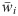
Analysis of market-order strategies.A, Distribution of w¯i quantifying the average strength of trend-following for market orders. The original samples wi are shown in Fig 4. A positive (negative) w¯i denotes a ith trader is a trend-follower (contrarian), and represented by a green (pink) plot bar. B, Average number of market orders (red) and that of transactions as market orders (blue) for each cluster. The gradation in plot bars presents a heat map of the ascending number of market orders and that of transactions as market orders by a trader in each cluster. Contrarians are active despite their small size. C,D, Failure probabilities of market orders in transactions (C) and the probabilities in which market orders are issued at prices better than the current best prices (D). The green (gray) bars and circles represent the strategic properties of trend-followers (random traders). The median failure probability of trend-followers (random traders) is 83% (24%), and the probability of trend-followers issuing market orders at better prices than the current best price is 70% (15%). Trend-follower may be attempting to obtain better prices than current best prices by submitting market orders in advance. E, Time-series of the ratio for the number of market orders issued by each cluster. Each bar represents the hourly average ratio. The dark-gray bars signify the fraction of market orders issued by LFTs.